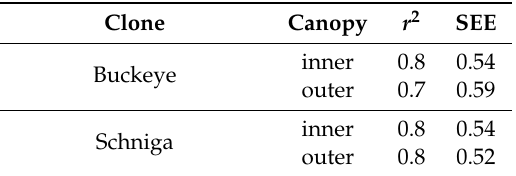
Table A5. Summary of linear regression for predicting SPI based on IAD measurements for season 2015. The regression was significant at p >